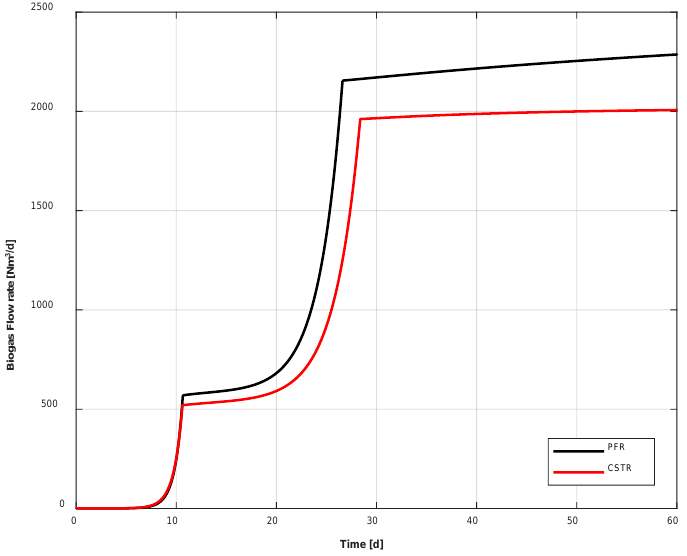
Figure 7. Comparison between the biogas flow rate in PFR and CSTR.